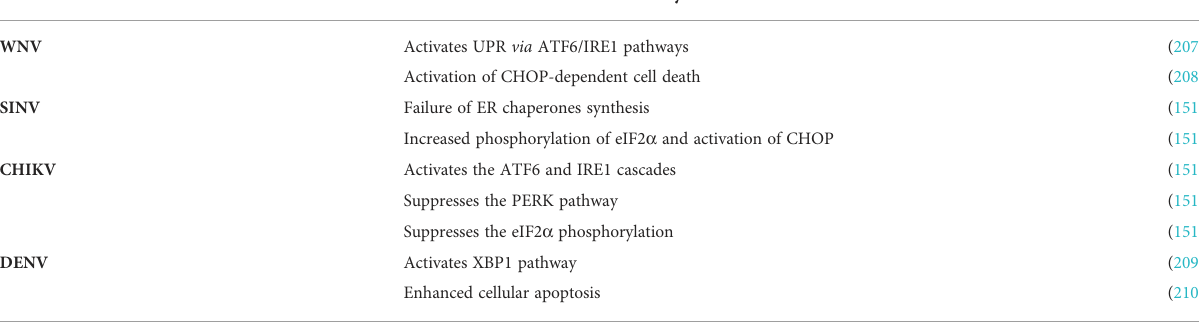
TABLE 5 Arboviruses and UPR